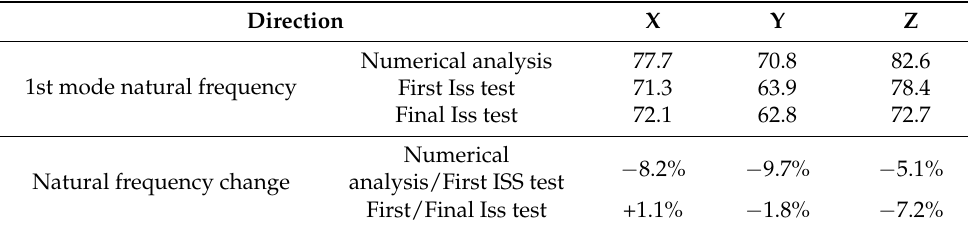
Table 8. Summary of natural frequency.